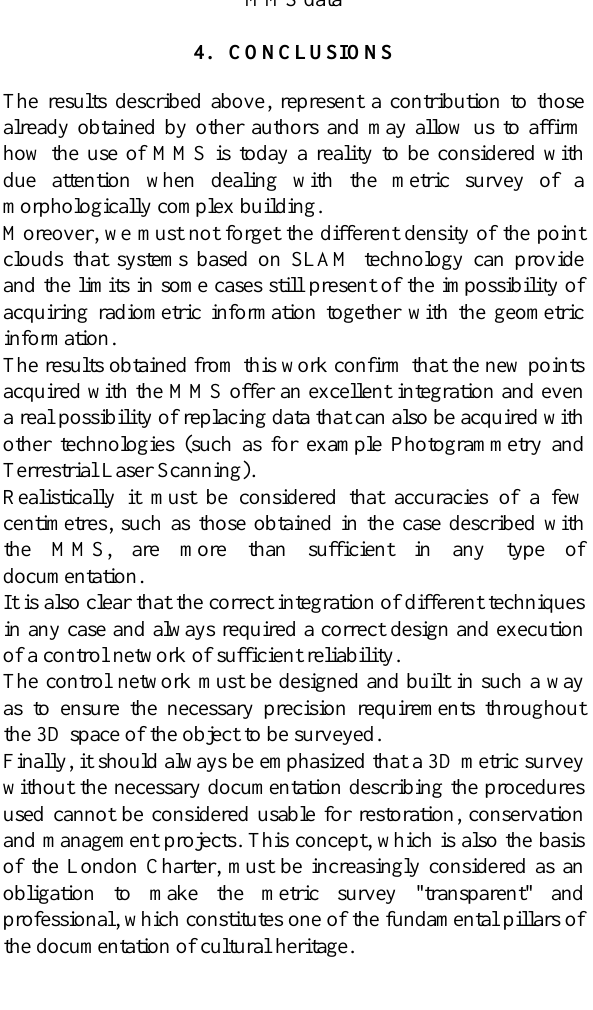
Table 8. Distance residuals after the second adjustment of MMS